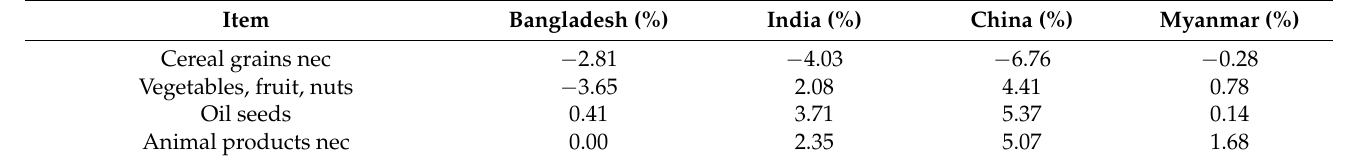
Table 1. Projections of changes in food consumption for selected food categories in Bangladesh, China, India, and Myanmar in 2030 under the urbanization